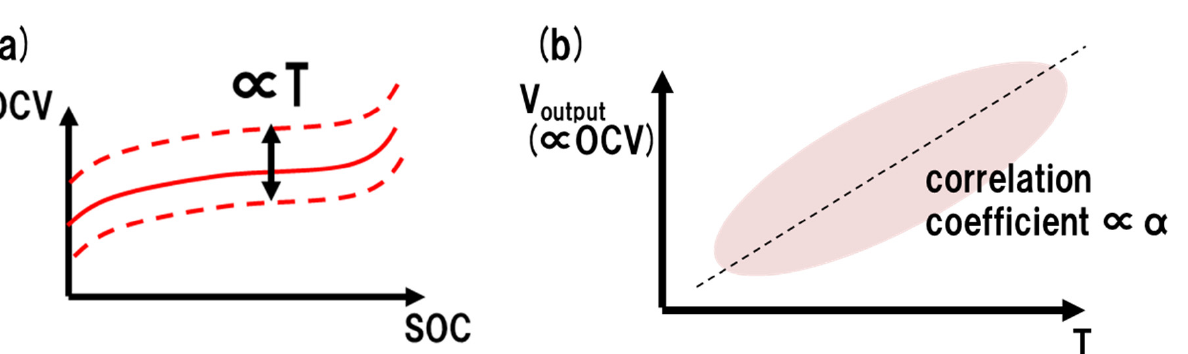
Figure 2. ( a ) OCV–SOC correlation temperature fluctuation correction. ( b ) Correlation chart between V output recorded as CAN data and outside temperature T .